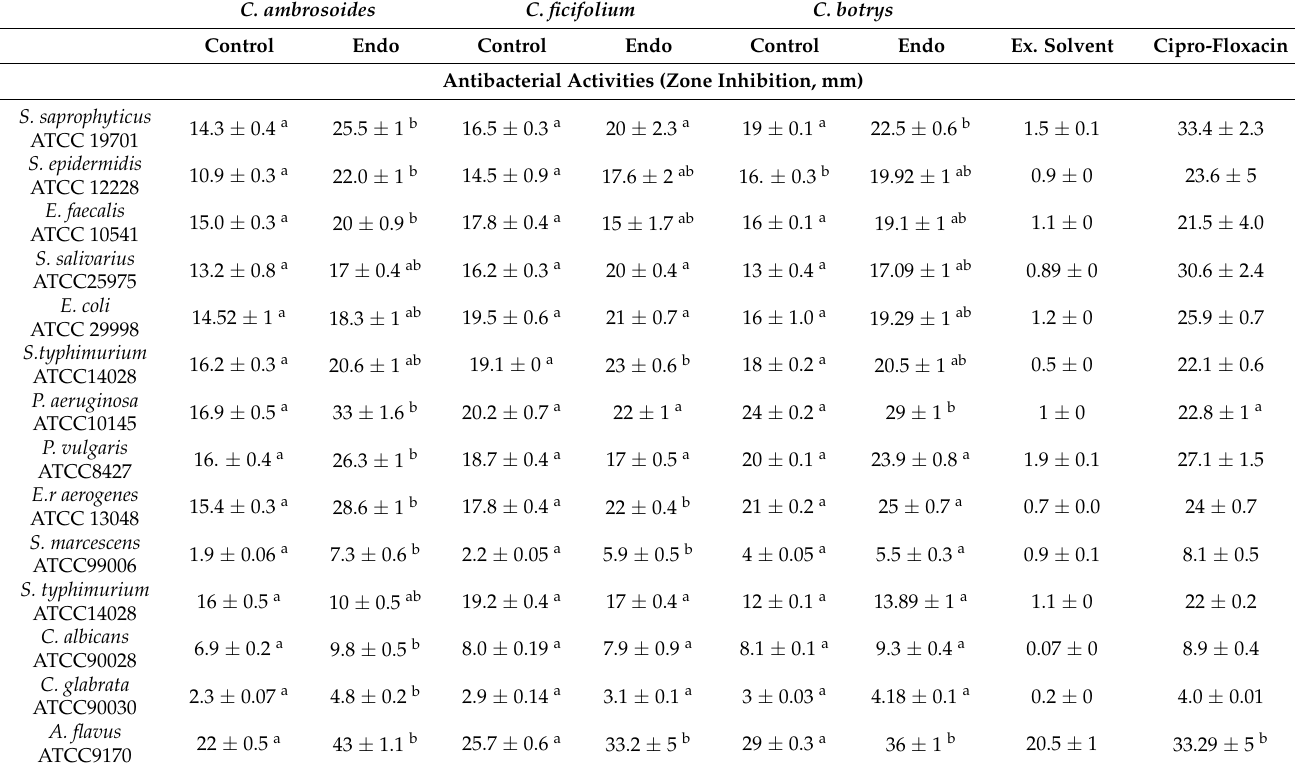
Table 6. Antibacterial activity of control and endophytic bacterial-treated Chenopodium ambrosoides, Chenopodium ficifolium, and Chenopodium botrys sprouts. Data are represented by the means of at least 3 replicates ± standard deviations. Different small letter superscripts (a, b) within a row indicate significant differences between control and endophytic bacterial samples.